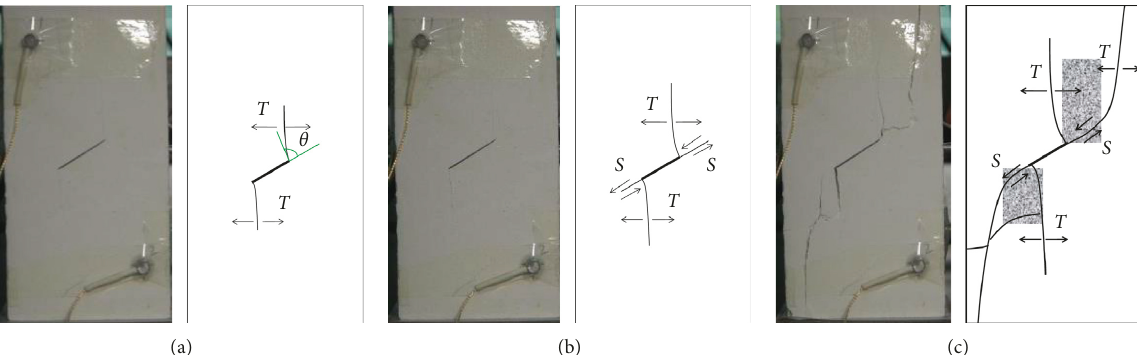
Figure 7: Crack initiation and propagation process of sample 30-2 under uniaxial compression: (a) wing crack initiation and propagation; (b) secondary crack initiation and propagation; (c) ultimate